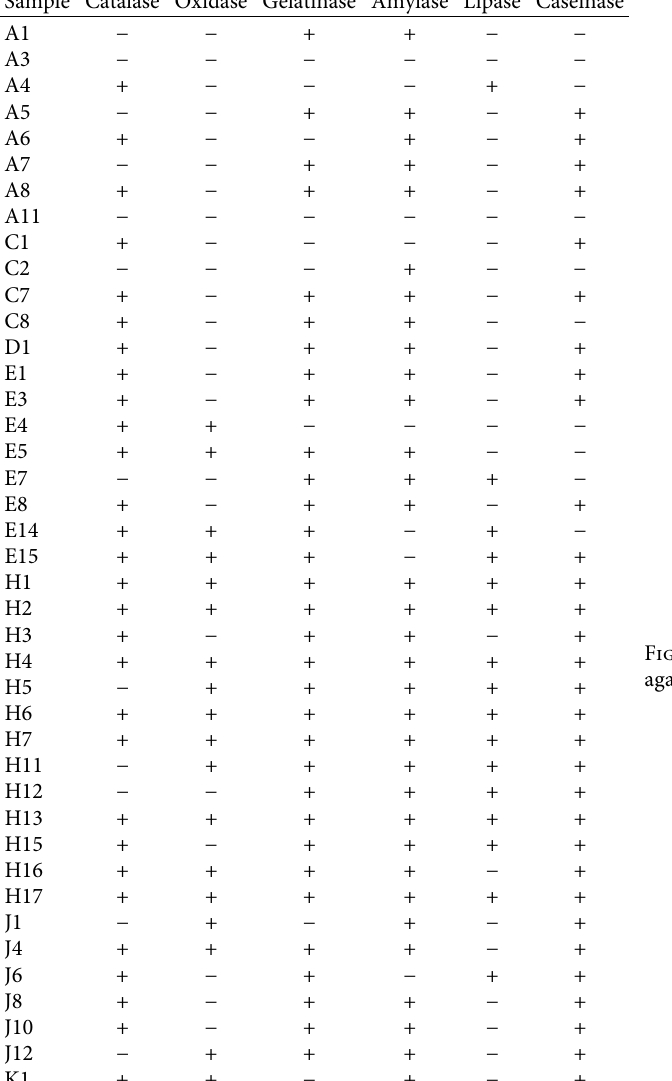
Table 2: Enzymatic characteristics of the isolates.